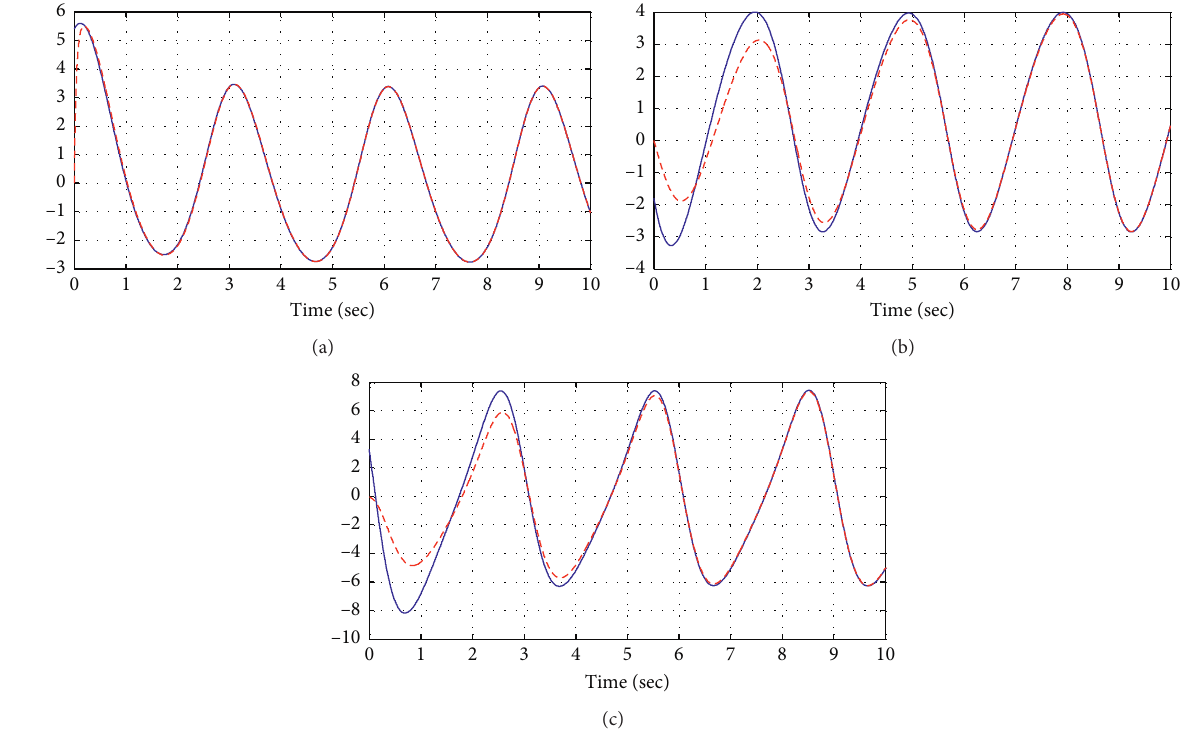
Figure 4: Observation process (true state, solid line; estimated state, dashed line) for (a) x